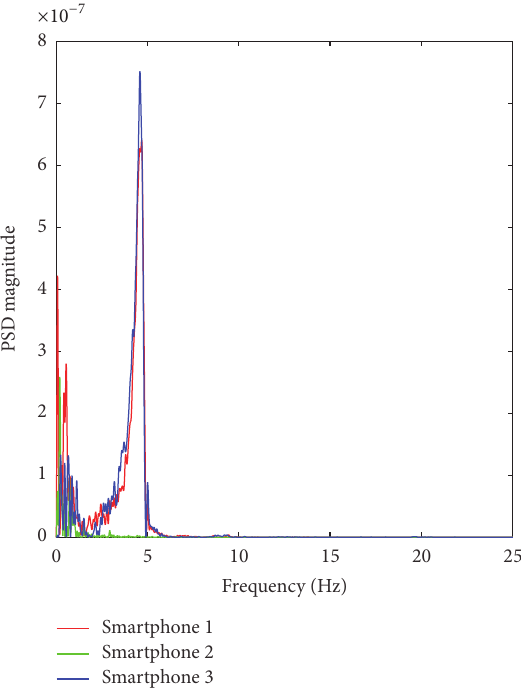
Figure 18: PSD of angle